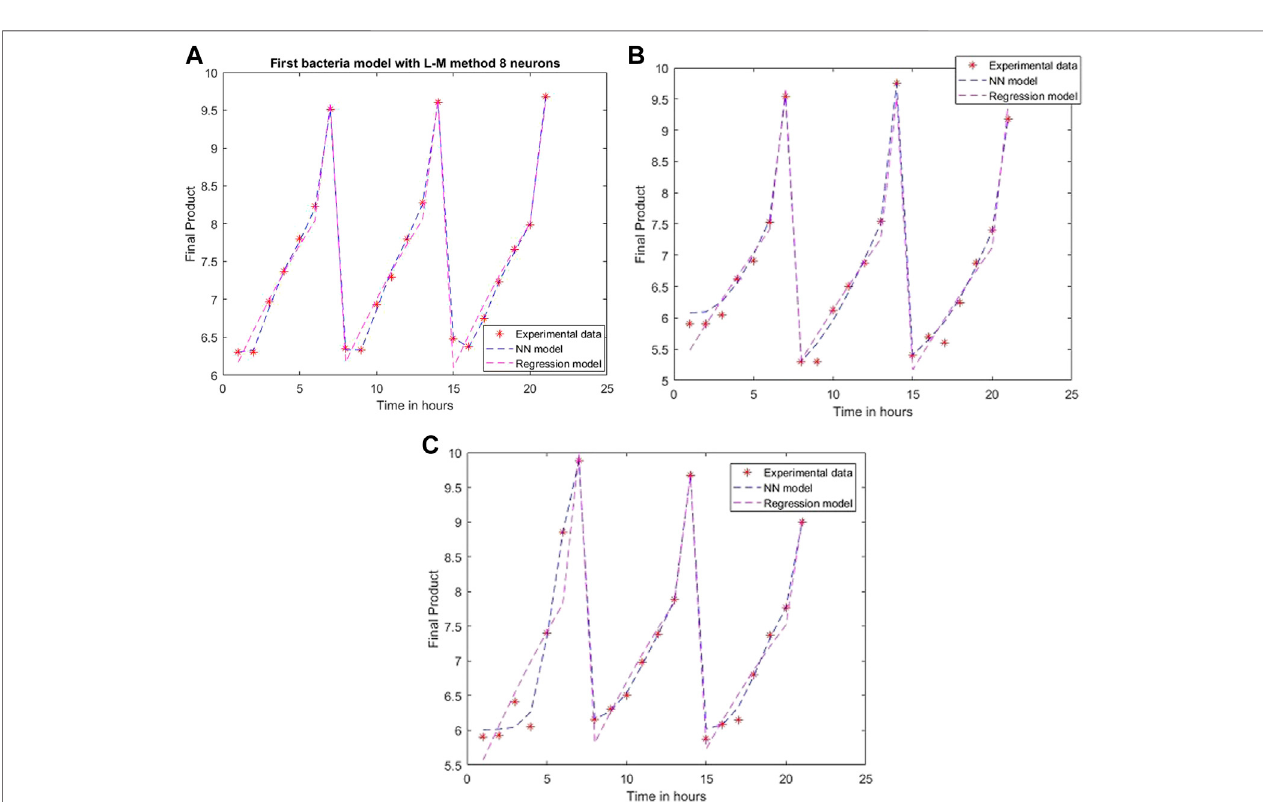
FIGURE 7 | Model results with Levenberg-Marquardt method and eight neurons for (A) L. plantarum ; (B) L. casei ; (C) co-cultures of L. plantarum and L. casei .